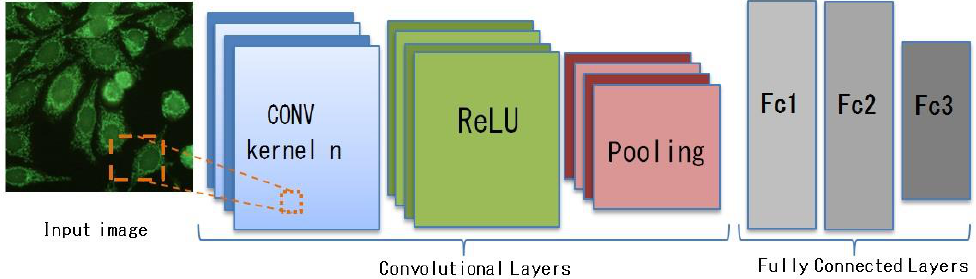
Figure 2. General scheme of the architecture of a the Convolutional Neural Network (CNN).